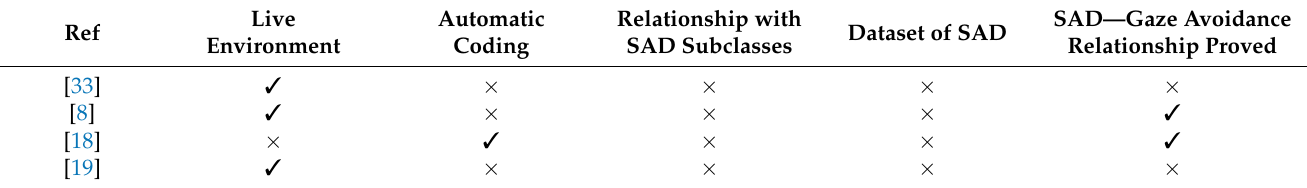
Table 1. Gaze interaction detection method to measure the SAD in a live communication studies